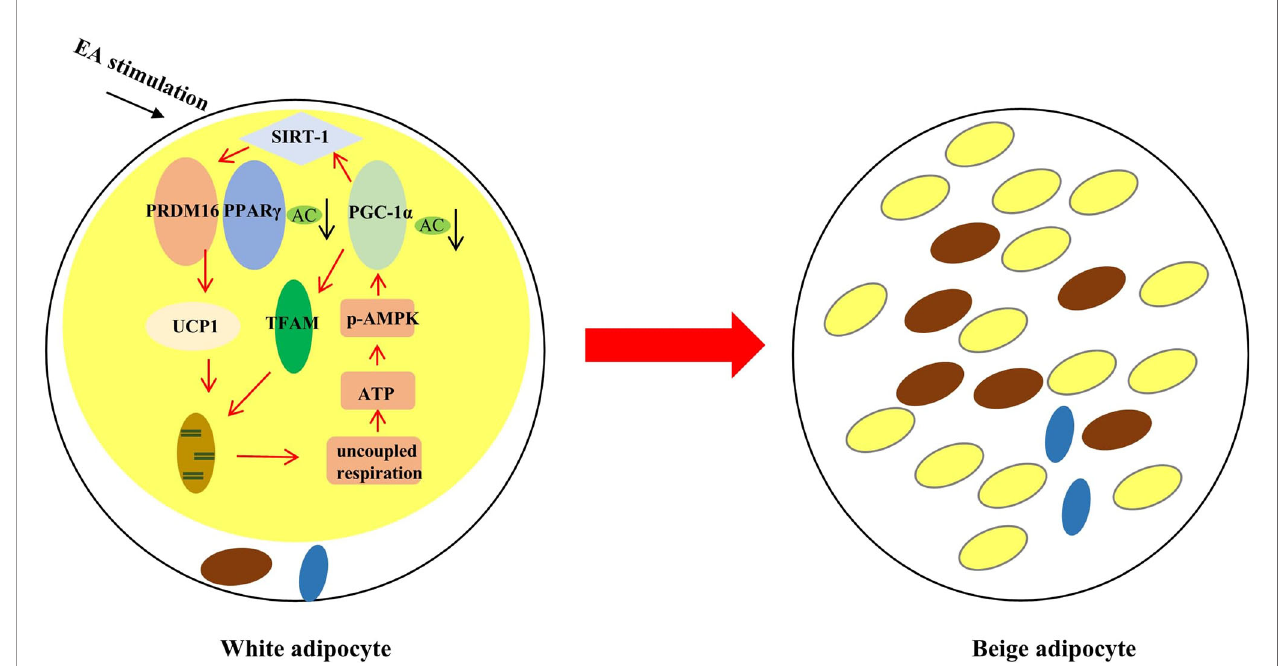
FIGURE 6 | The effect of EA stimulation on WAT. EA can remodel WAT to BAT through inducing SIRT-1 dependent PPAR g deacetylation, and regulating PGC-1 a - TFAM-UCP1 pathway to induce mitochondrial biogenesis. The red rows mean promotion, and the black rows mean